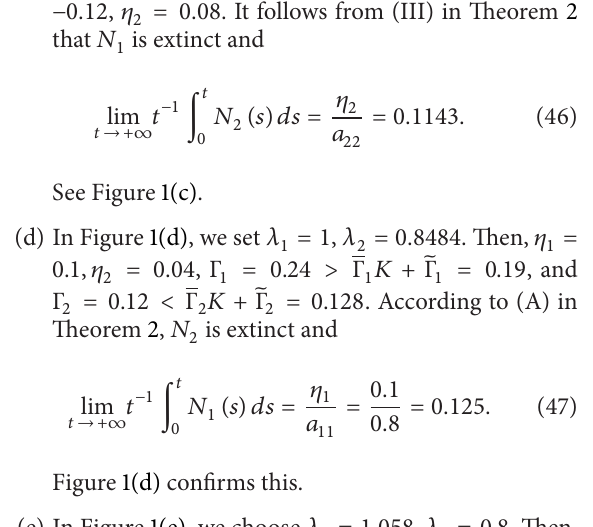
= 1.1, 𝜆 = 1 ; (b) is with 𝜆 = 1 , 𝜆 = 1 ; (c) is with 𝜆 1 2 1 2 = 1.058 , 𝜆 = 0.8 ; (f) is with 𝜆 = 1 , 𝜆 = 0.8 1 2 1 2